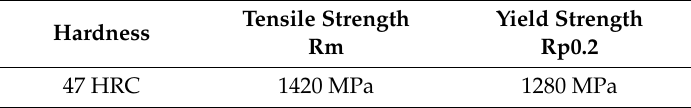
Table 2. Rheological properties of machined material.